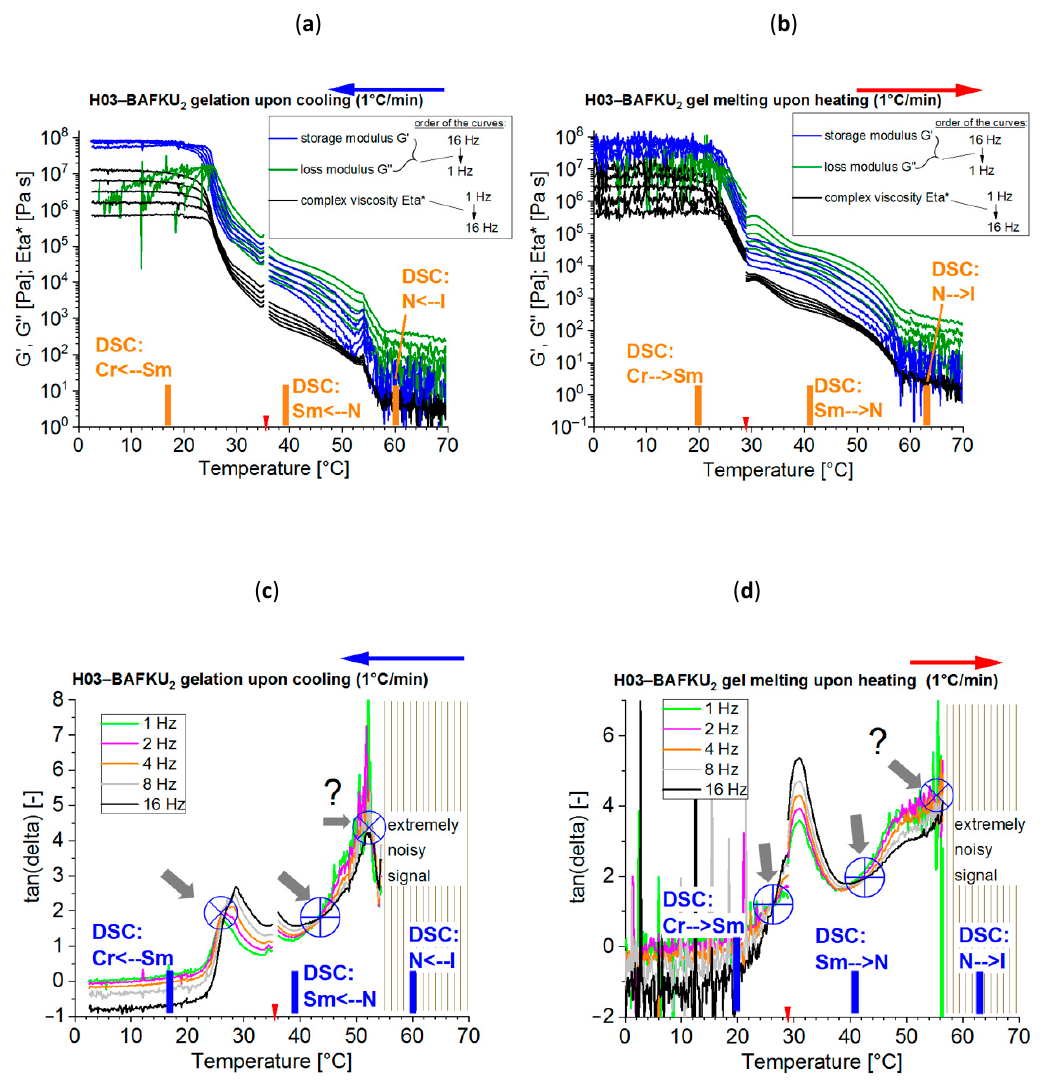
Figure 1. Multi-frequency temperature ramp tests carried out in the melting and rubbery temperature Figure 1. regions of H03–BAFKU 2 : ( a , b ): temperature dependence of the storage shear moduli G (cid:48) of the loss moduli G ” of the complex viscosities Eta* recorded at the simultaneously applied frequencies of 1, 2, 4, 8 and 16 Hz; ( a ): cooling scan; ( b ): heating scan; ( c , d ): detail of the sets of the tan δ curves with marked crossover (or near-crossover) points; ( c ): cooling scan, ( d ): heating scan; red markers indicate change in